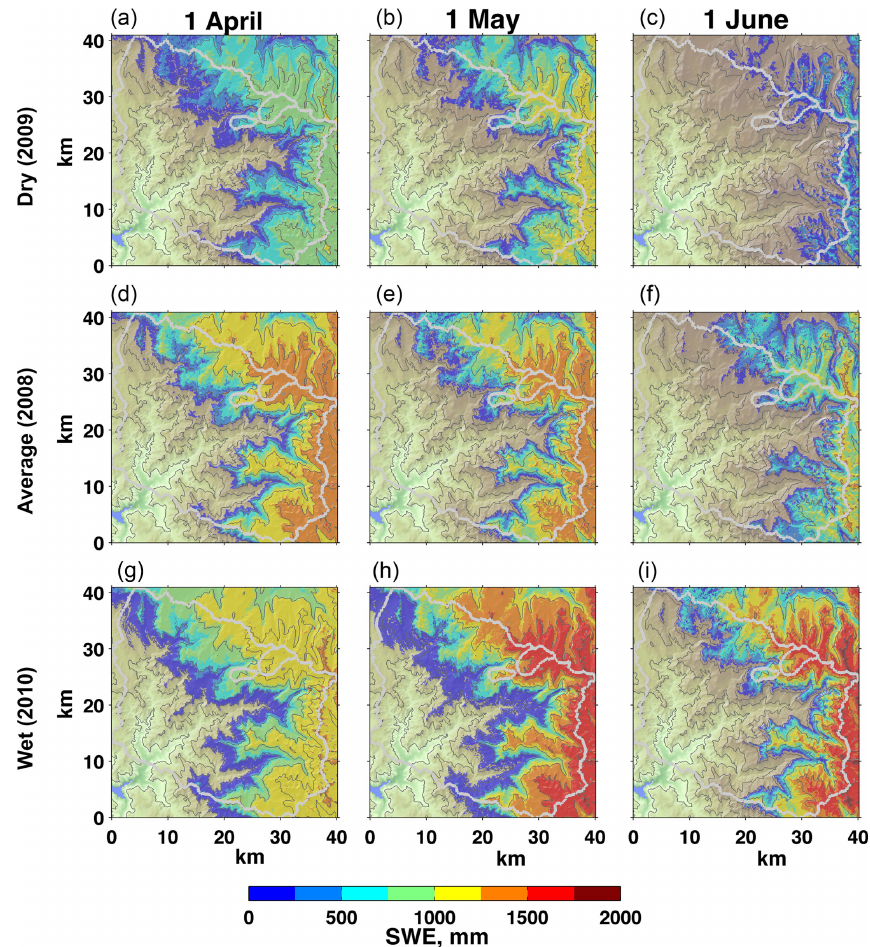
Figure 2. Simulated SWE over the greater Kaweah River basin on the first of April (a, d, h) , May (b, e, i) , and June (c, f, j) for a moderately dry water year (2009; a, b, c ), near-climatological-average water year (2008; d, e, f ), and a moderately wet water year (2010; g, h, i